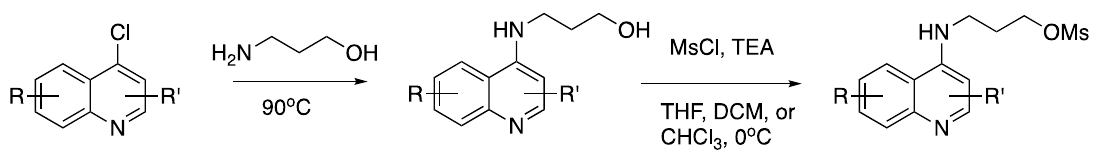
Figure 5. Reaction of 4-chloroquinolines with 3-amino-1-propanol, followed by activation of the resulting alcohol by methanesulfonyl chloride.